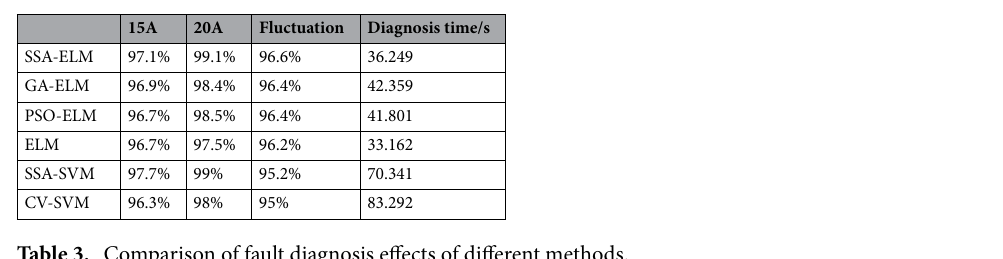
Table 3. Comparison of fault diagnosis effects of different